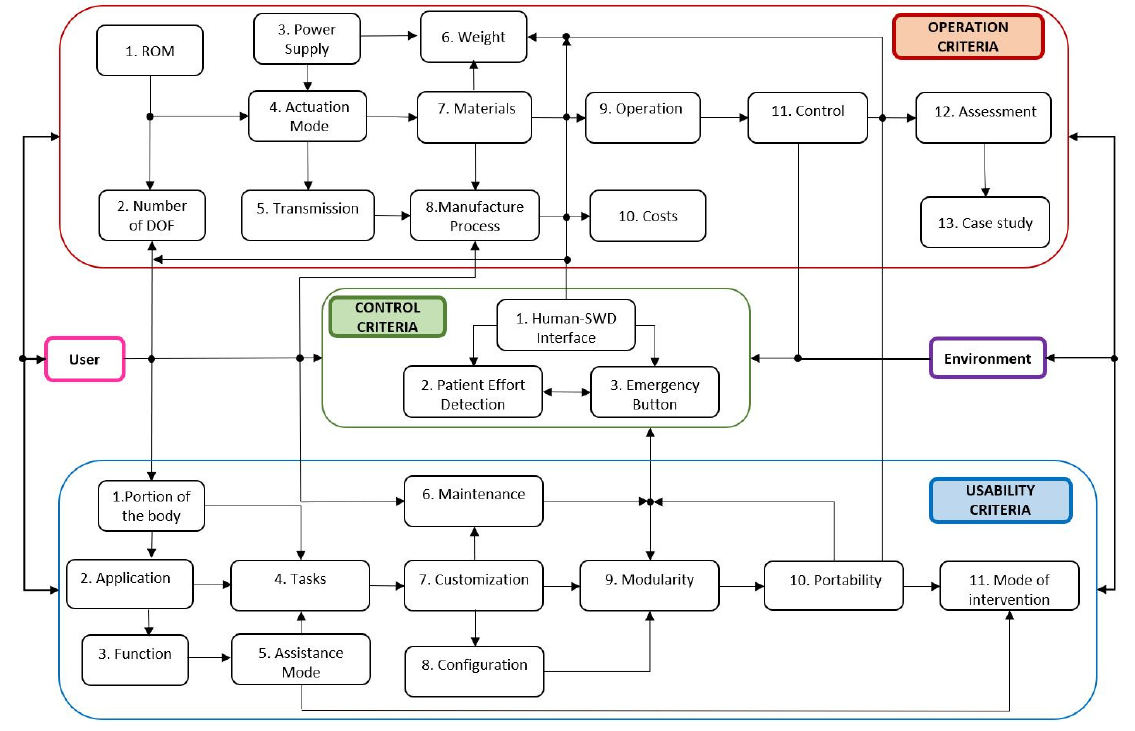
Figure 3. Design criteria for soft wearable